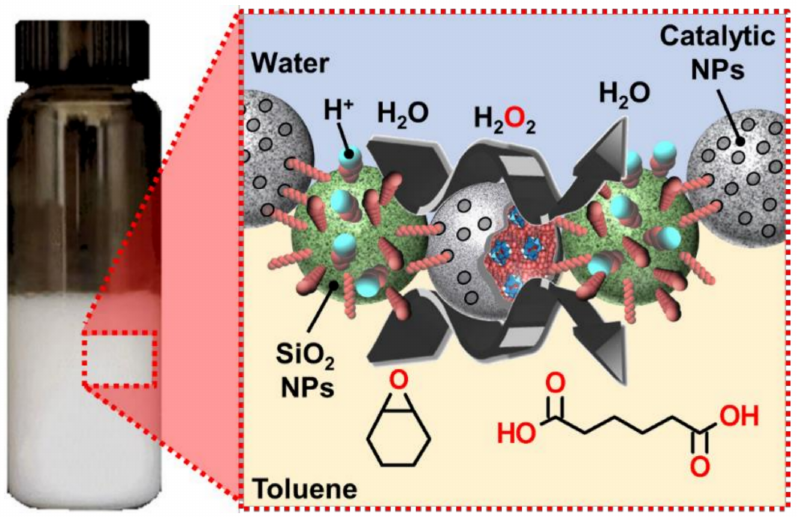
Figure 63. A schematic representation of Pickering oxidative cleavage of epoxycyclohexane in a water-in-toluene Pickering emulsion stabilized with amphiphilic dodecyltrimethylammonium/ PW 12 O 40 and modified silica